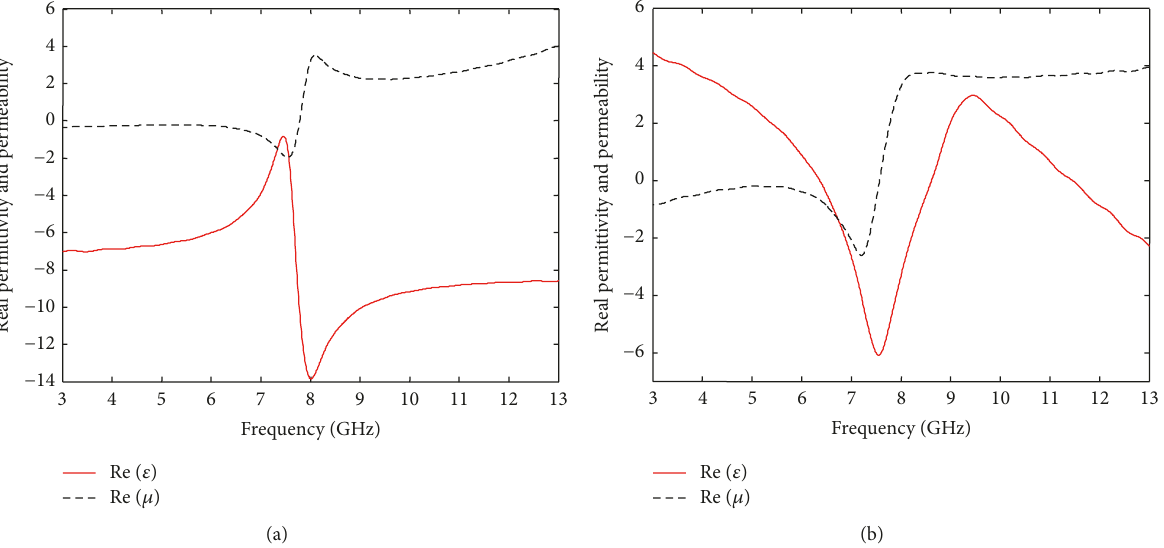
Figure 5: Real permittivity and permeability of (a) circular and (b) rectangular EBG structures.